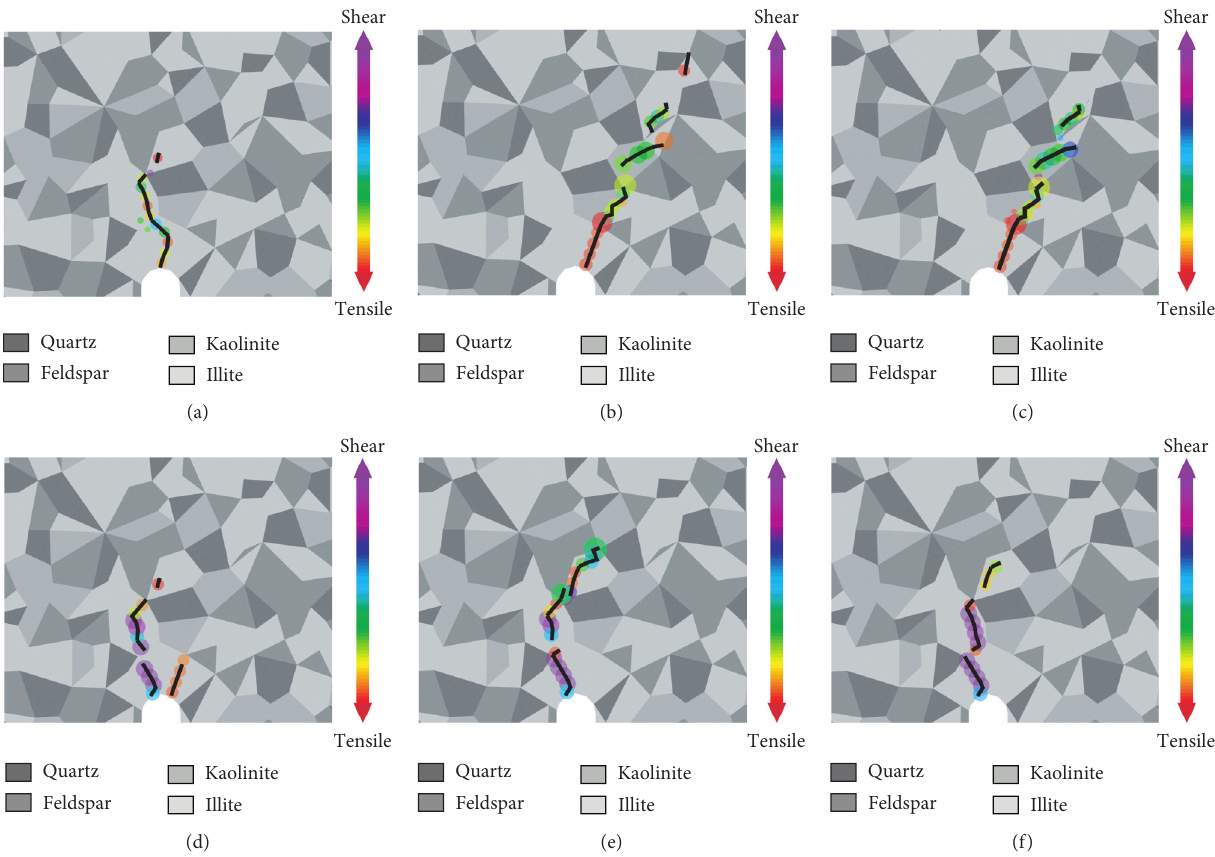
Figure 10: The initiation of small-scale en echelon intermittent fractures under six different load methods. Red dots are the AE location of tensile fractures, purple dots are the AE location of shear fractures, and the colors between the two are the AE location of tensile-shear fractures. The size of the dot represents the level of AE